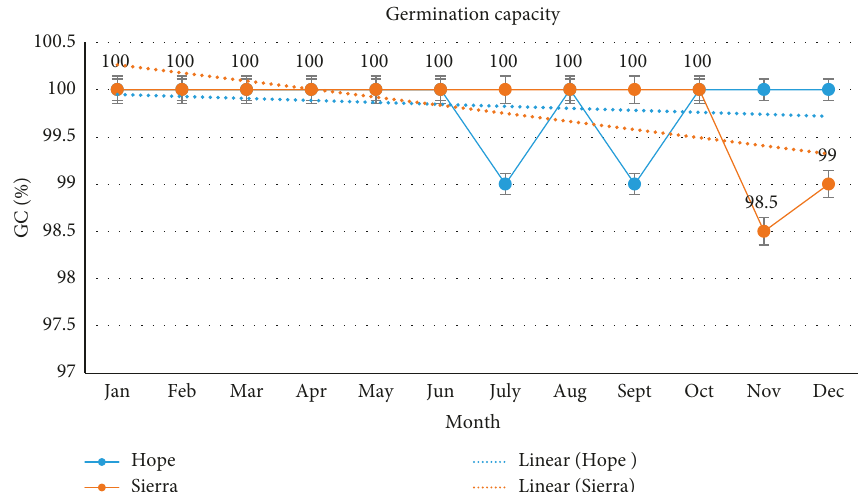
Figure 1: Comparison of germination capacity trends for Hope and Sierra malting barley varieties over the 12-month storage period.